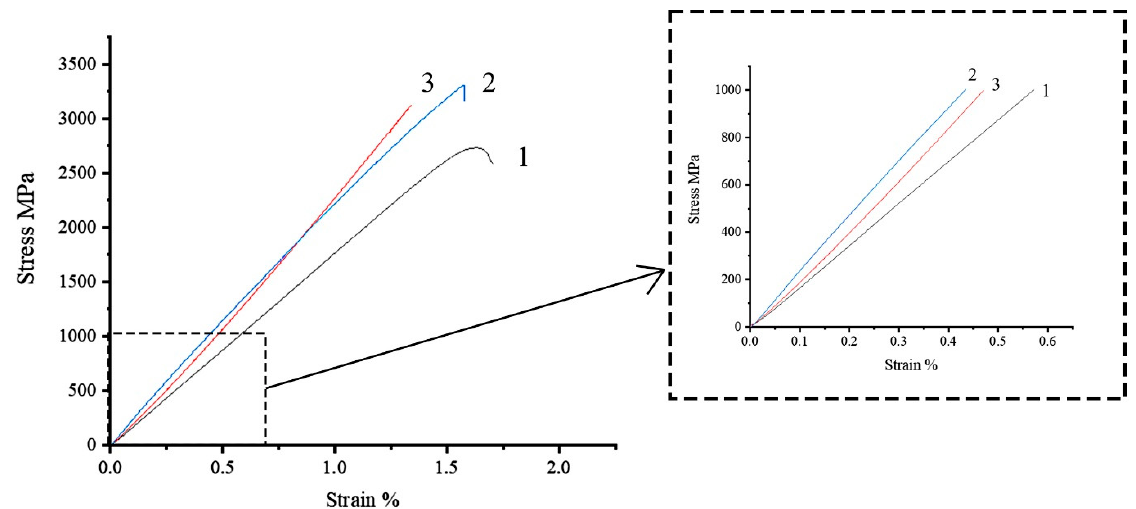
Figure 3. Strain–stress diagrams for samples based on high-strength fiber Toray T700. Test speed 10 mm/min. 1–unimpregnated fiber; 2–fiber impregnated with epoxy binder; 3–fiber impregnated with polysulfone.